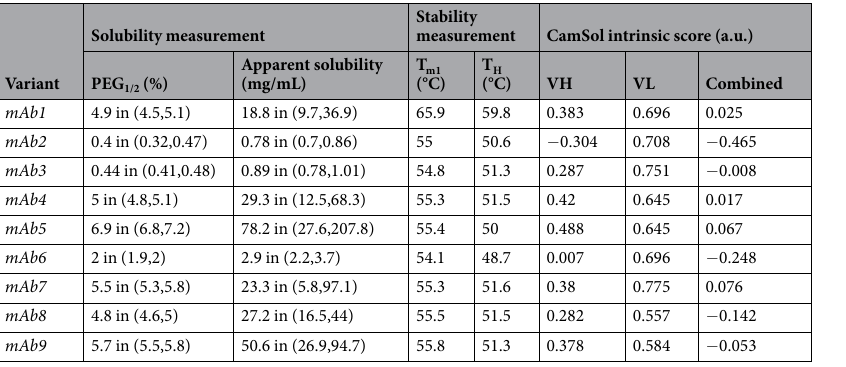
Table 1. Solubility scores, solubility and stability measurements for all mAb variants studied in this work. PEG 1/2 and the apparent solubility are estimated from the fitting of the data points in Figures 3 and S2, respectively. Numbers in brackets are the lower and upper 95% confidence interval calculated with 10 4 bootstrap cycles. Stability measurements T m1 and T H have been performed respectively with DSC and DSF (see Methods). The CamSol scores are reported for the sequences of the VH domain, the VL domain, and for the combined VH-VL complex (see